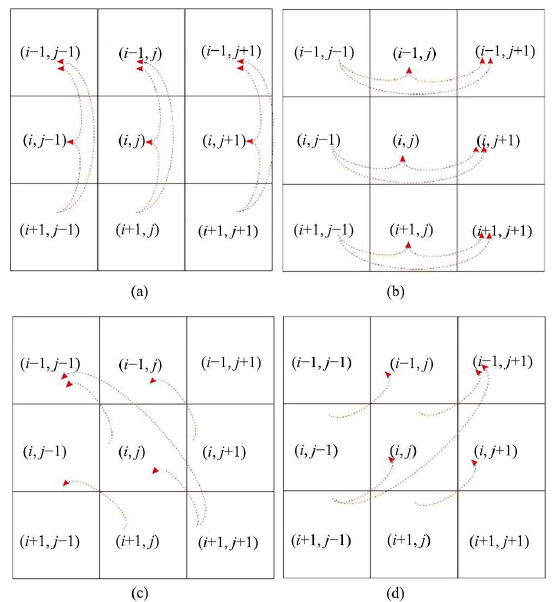
Figure 2. A sliding window for a 3 × 3 matrix of variance statistics for fractal surfaces. ( a ) Southnorth direction; ( b ) eastwest direction; ( c ) southeastnorthwest direction; ( d ) northeastsouthwest direction. The red arrows represent the direction of movement during calculation.